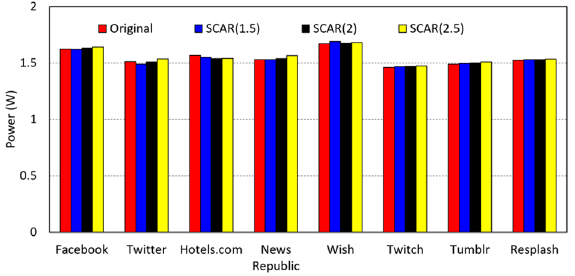
Figure 19. Power consumption in down-scrolling.